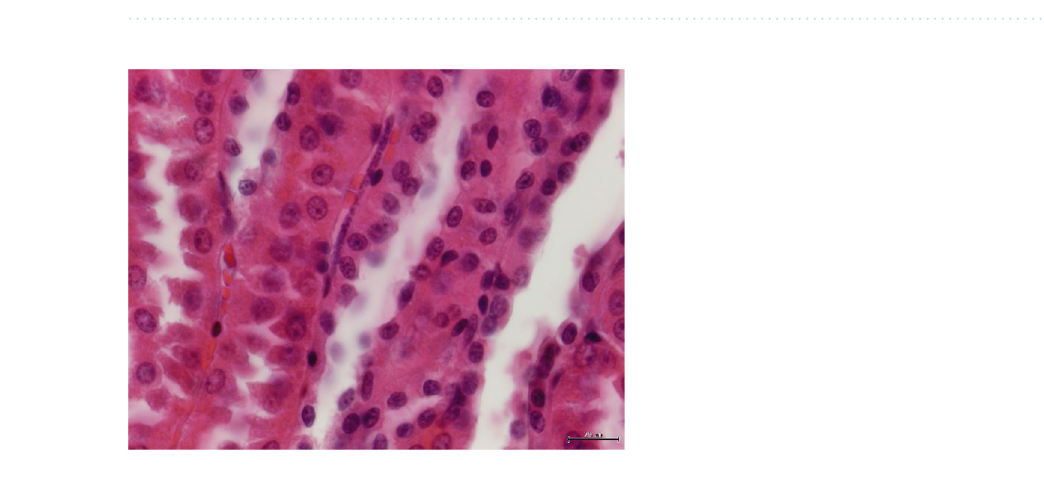
Figure 3. Liver from hare-1. Presence of a microfilaria inside a sinusoid. ×400, H&E.